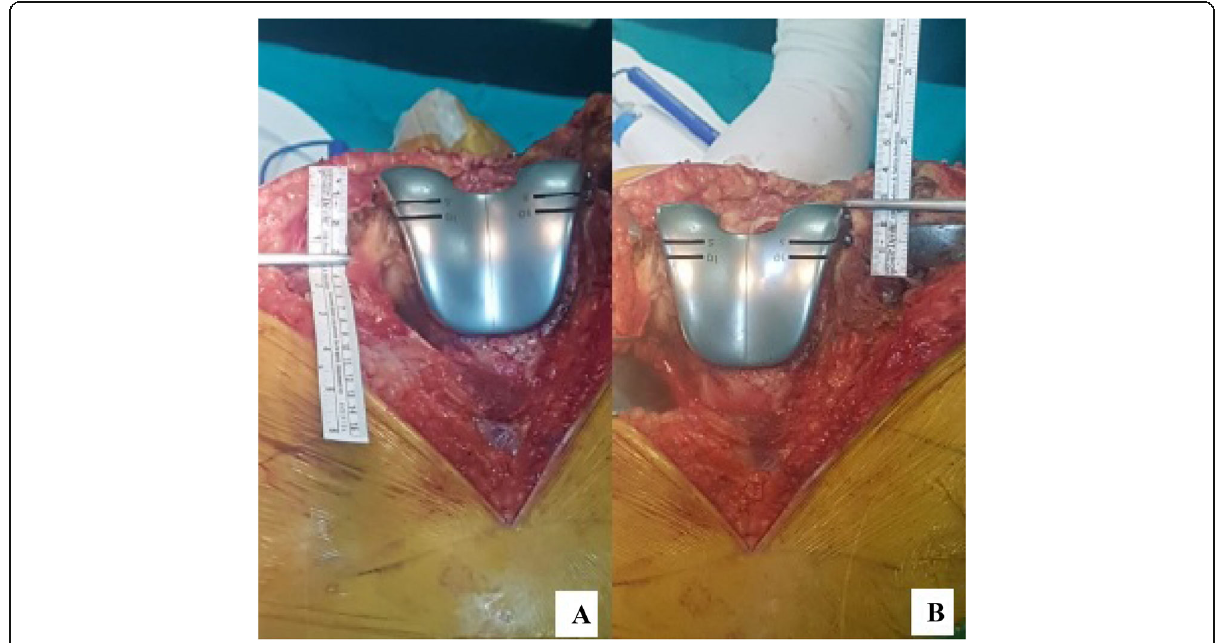
Fig. 2 Joint line restoration with femoral femoral trial prothesis according to calculations. a. ME-JL. b.